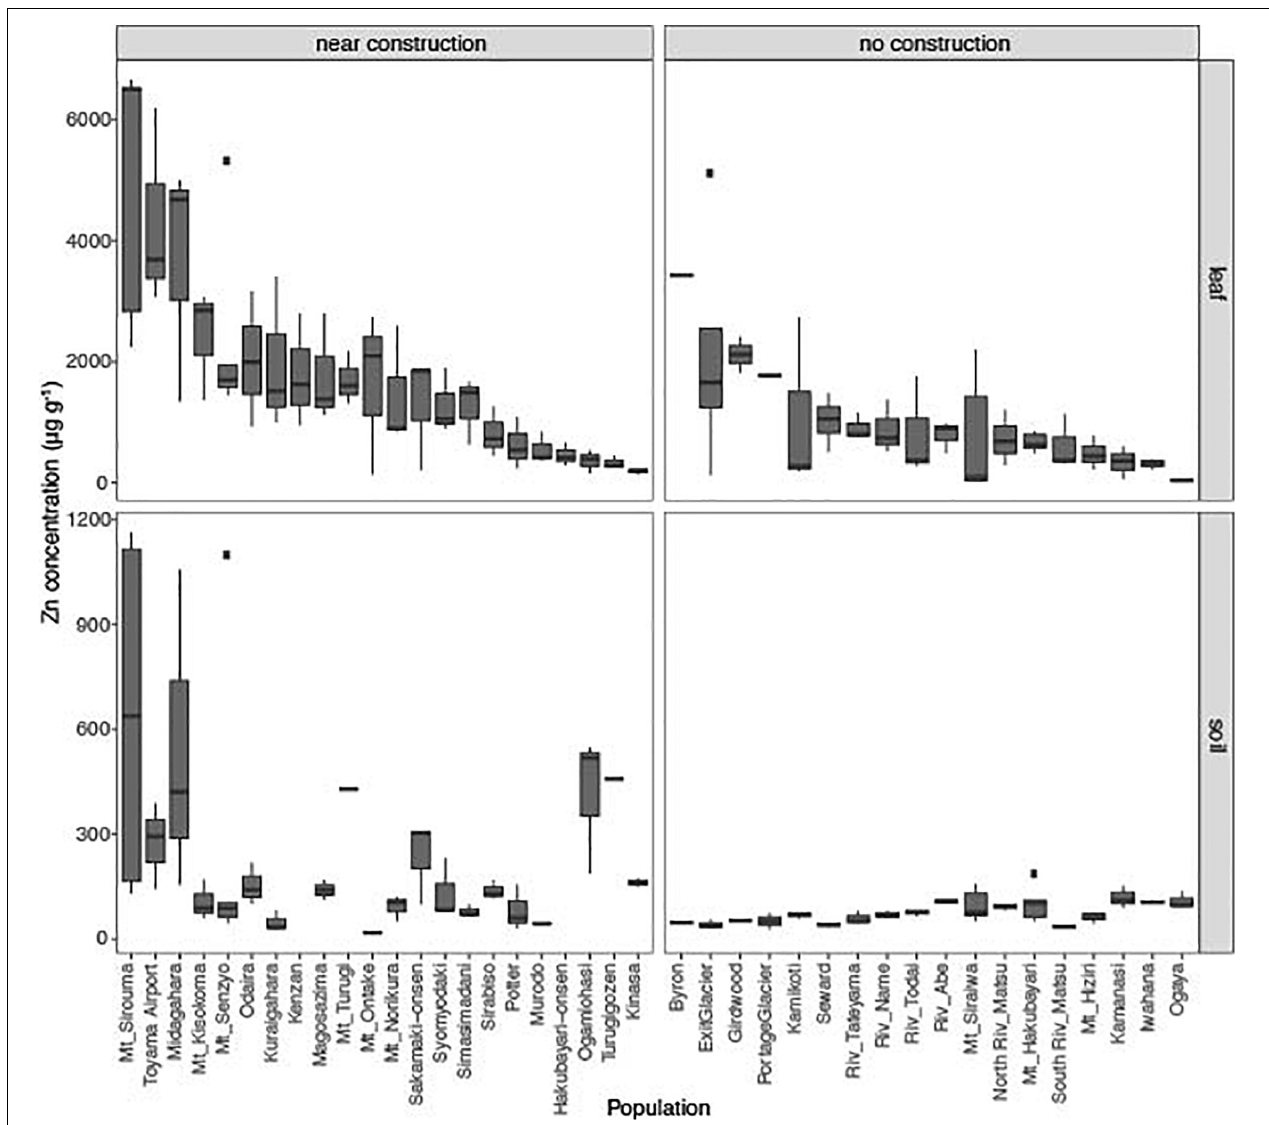
FIGURE 1 | Leaf concentrations of zinc (Zn) from 40 natural populations of A. kamchatica (Upper) . Soil concentrations of Zn (Lower) at 38 corresponding sites. Populations were grouped into near construction or no construction types. The populations are sorted from highest to lowest Zn concentration in the leaf samples. The y -axis is the Zn concentration in µ g per gram of dry weight. Note different y -axis scales for leaf and soil samples. Boxplots: center line, median; box limits, upper and lower quartiles; whiskers, 1.5 × interquartile range; points, outliers. The correlations between leaf accumulation and soil concentrations: Pearson’s r = 0.68 (near construction), Pearson’s r = 0.007 (no construction) (see also Supplementary Figure 1 ). Refer to Supplementary Table 1 for mean values, variance, number of replicates, and location